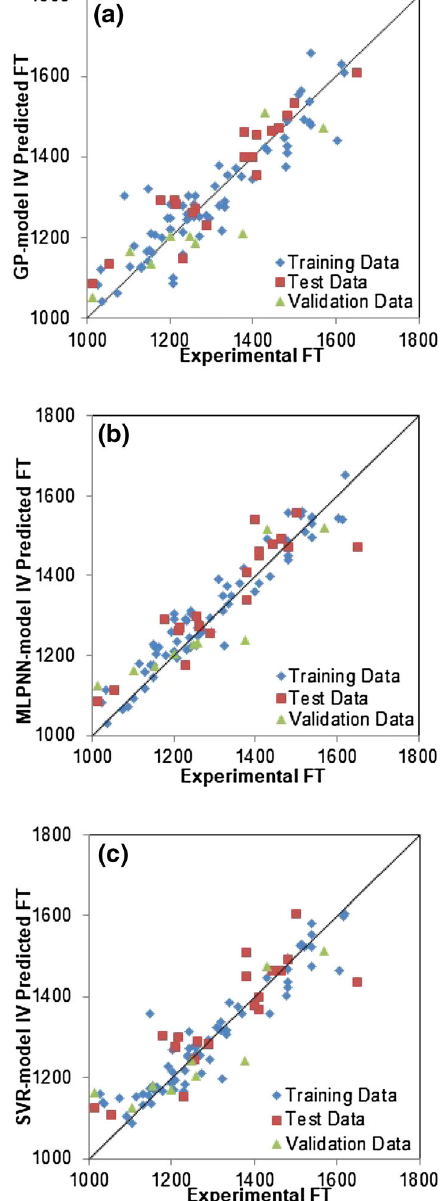
Fig. 11 Plots of experimental FT values versus those predicted by the GP (panel a ), MLP (panel b ), and SVR based (panel c )